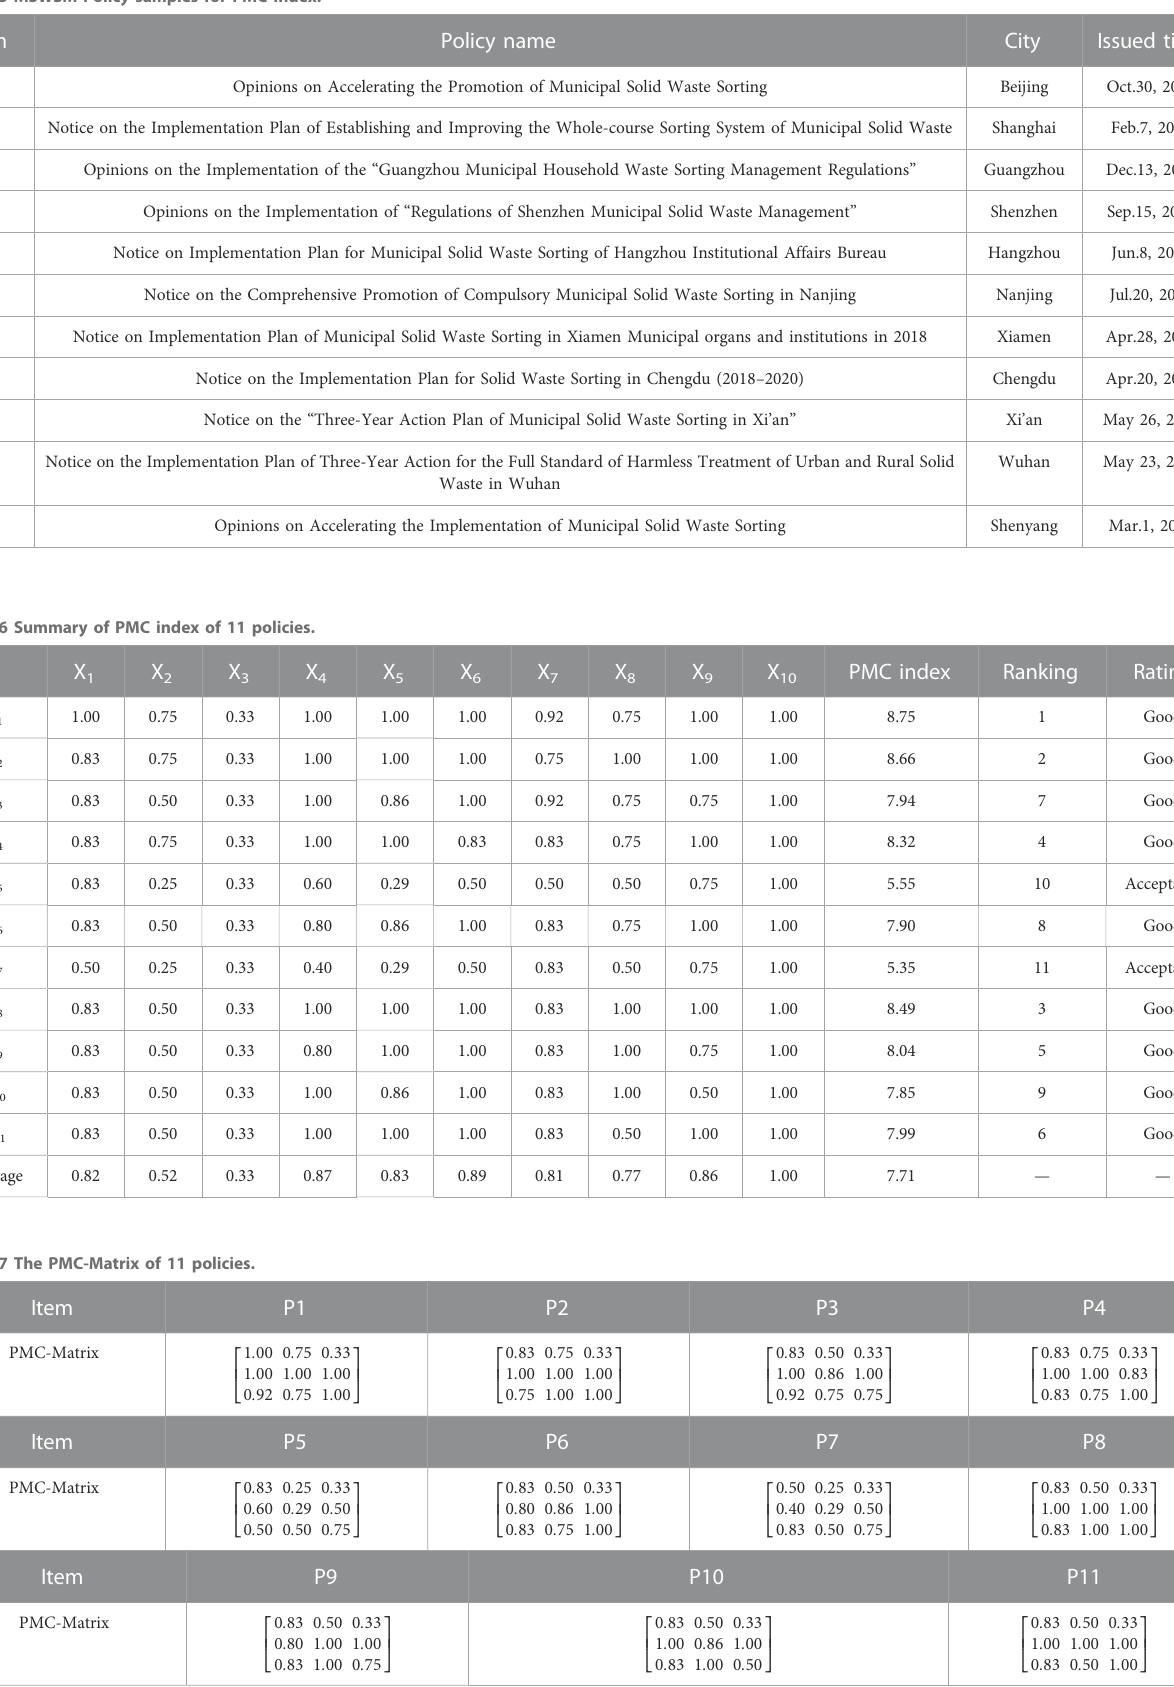
TABLE 5 MSWSM Policy samples for PMC Index.